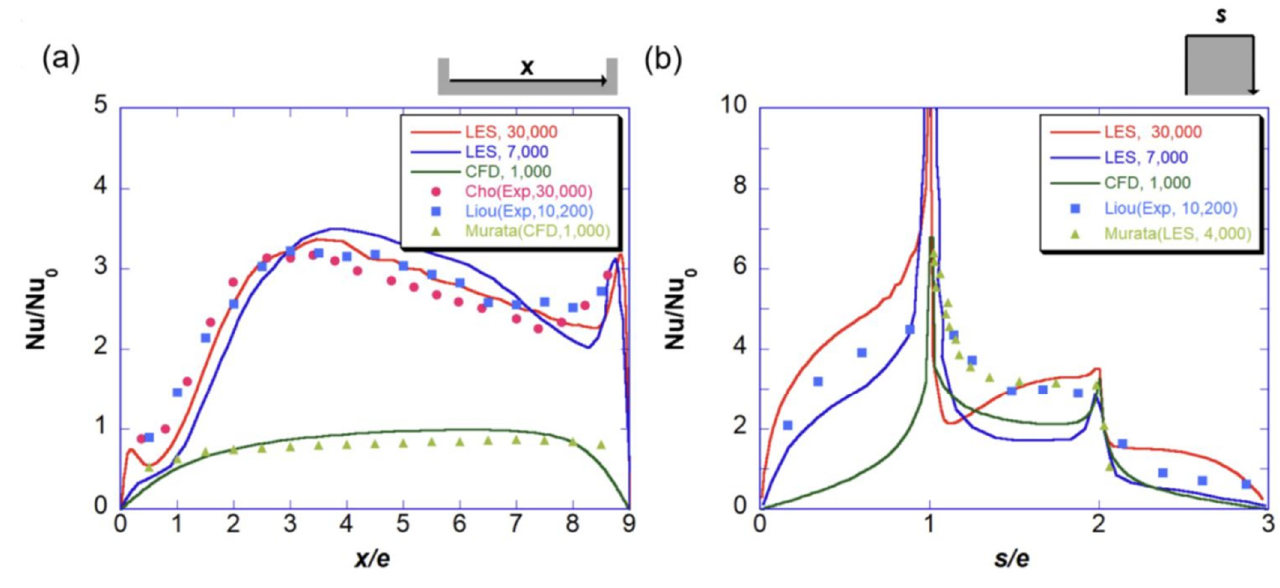
Figure 4. Effect of Reynolds number on the local Nusselt number along the wall; ( a ) Nusselt number along the interface between the ribs and ( b ) Nusselt number on the rib. along the interface between the ribs and ( b ) Nusselt number on the